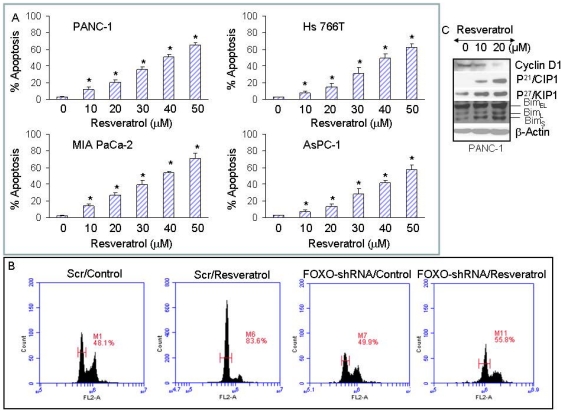
Effect of resveratrol on apoptosis and cell cycle.(A), Pancreatic cancer PANC-1, MIA PaCa-2, Hs 766T and AsPC-1 cells were treated with resveratrol (0–30 µM) for 48 h and apoptosis was measured by TUNEL assay. Data represent the mean ± S.D. * = significantly different from respective controls, P<0.05. (B), PANC-1 cells were transfected with either scrambled or FOXO1/FOXO3a/FOXO4 shRNA expressing constructs and treated with resveratrol (10 µM) for 24 h. At the end of incubation period, cells were harvested, and cell cycle analysis was performed by flow cytometry. (C), Effects of resveratrol on cell cycle regulatory genes. PANC-1 cells were treated with resveratrol (0–20 µM) for 24 h. The expression of cyclin D1, p21/CIP1, p27/KIP1 and Bim was measured by Western blotting. Anti β-actin antibody was used as a loading control.